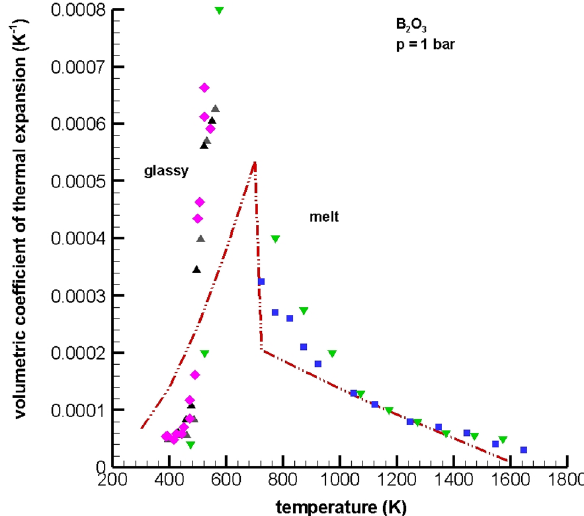
Figure 4. Volumetric coefficient of expansion vs temperature for boron trioxide at 1 bar. Experimental data: Napolitano et al. 48 ( ), Spaght and Parks 52 ( )—partially and carefully annealed (sample 1), Spaght and Parks 52 ( ) —partially and carefully annealed (sample 2), Fajan and Barber 54 ( ). Simulation data: moving boundary equation with soft repulsion/temperature-dependent boroxol ring structure ( ).